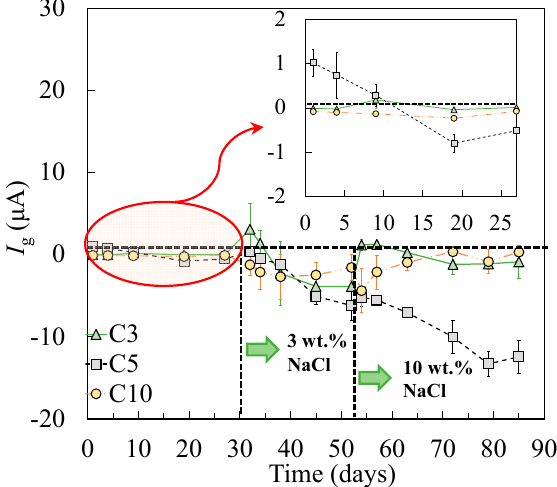
Figure 11. The galvanic current between the stressed and non-stressed steels.